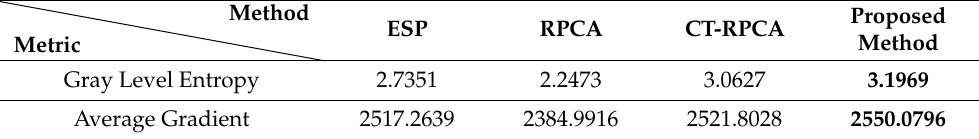
Table 4. Gray level entropies and average gradients after ESP, RPCA, CT-RPCA, and proposed